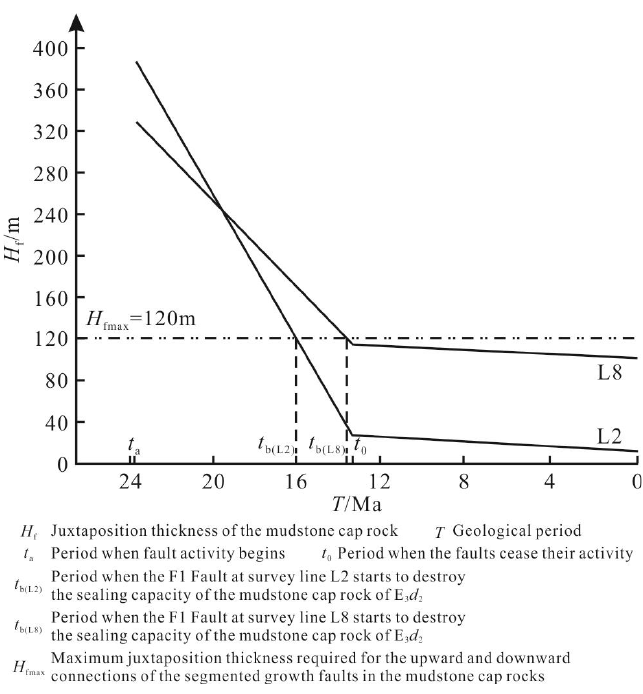
Figure 6. Determination of the period when the F1 Fault begins to destroy the sealing capacity of the mudstone cap rock of E 3 d 2 .